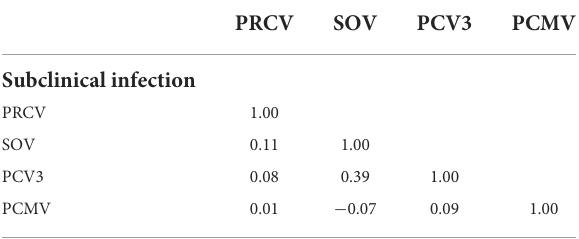
TABLE 5 Tetrachoric correlation matrix for results of nasal swabs collected in asymptomatic infected